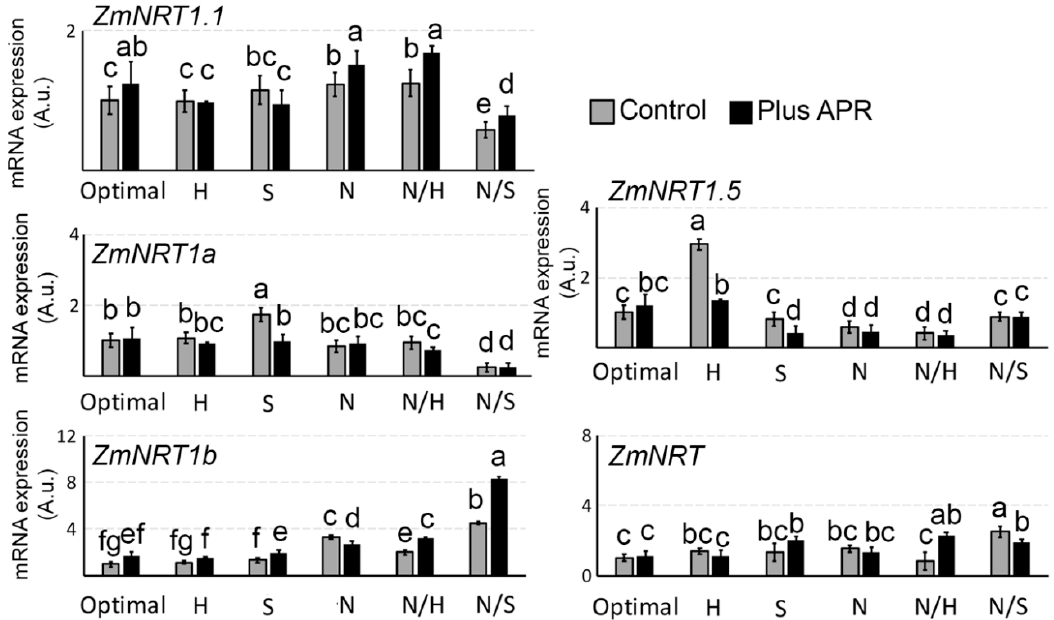
Figure 6. The gene expression patterns of nitrate transporters belonging to the Low Affinity Transport Systems (LATS) maize gene family in response to different single and combined abiotic stress are influenced by the presence of APR ®. Q-PCR analyses were carried out on root of stressed (H, S, N, N/H, N/S) or unstressed (optimal) maize seedlings grown for 3 days in absence (grey bars) or in presence (black bars) of 5% APR®. Relative mRNA level represents data normalized to control (Optimal = 1). The values shown are means of three biological replicates ± SE. Significantly different values ( p < 0.05) are evidenced by different letters (One-way Anova, LSD post-hoc